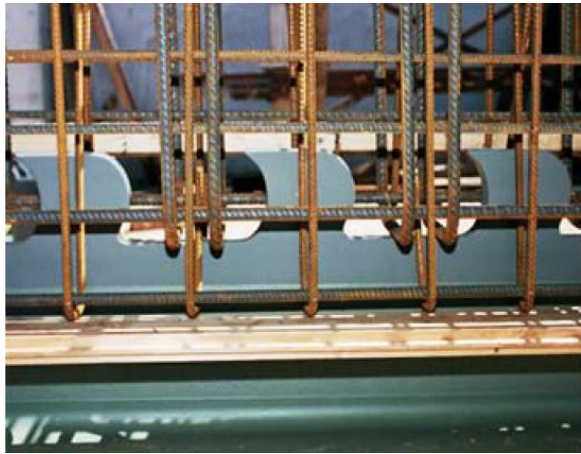
Figure 11: Modified SA shape (without the sharp notch) used in the Vigaun Bridge